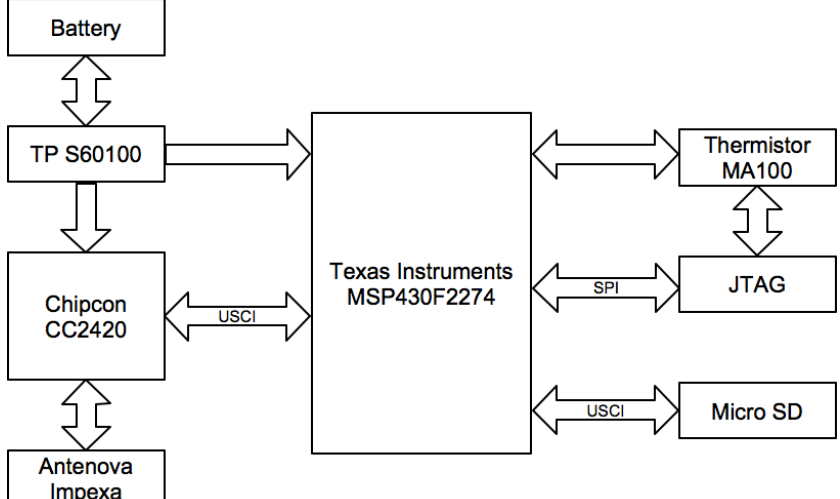
Figure 3. Biosensor architecture block